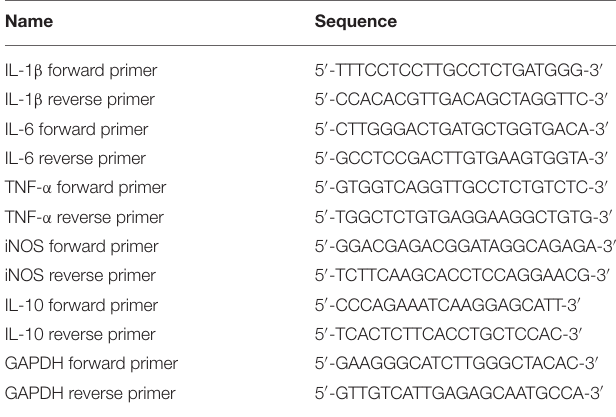
TABLE 1 | Primers used for quantitative reverse transcription polymerase chain